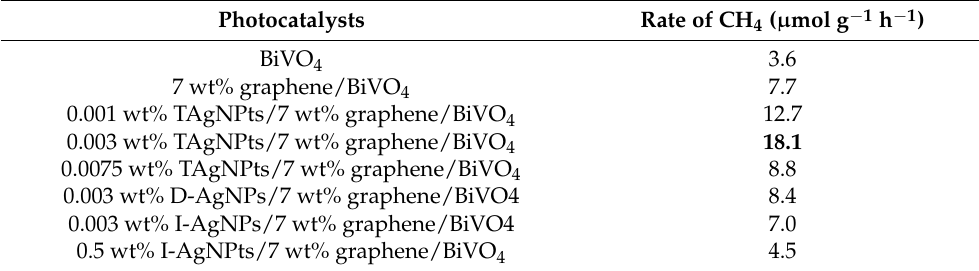
Table 4. Production rate of CH 4 on various